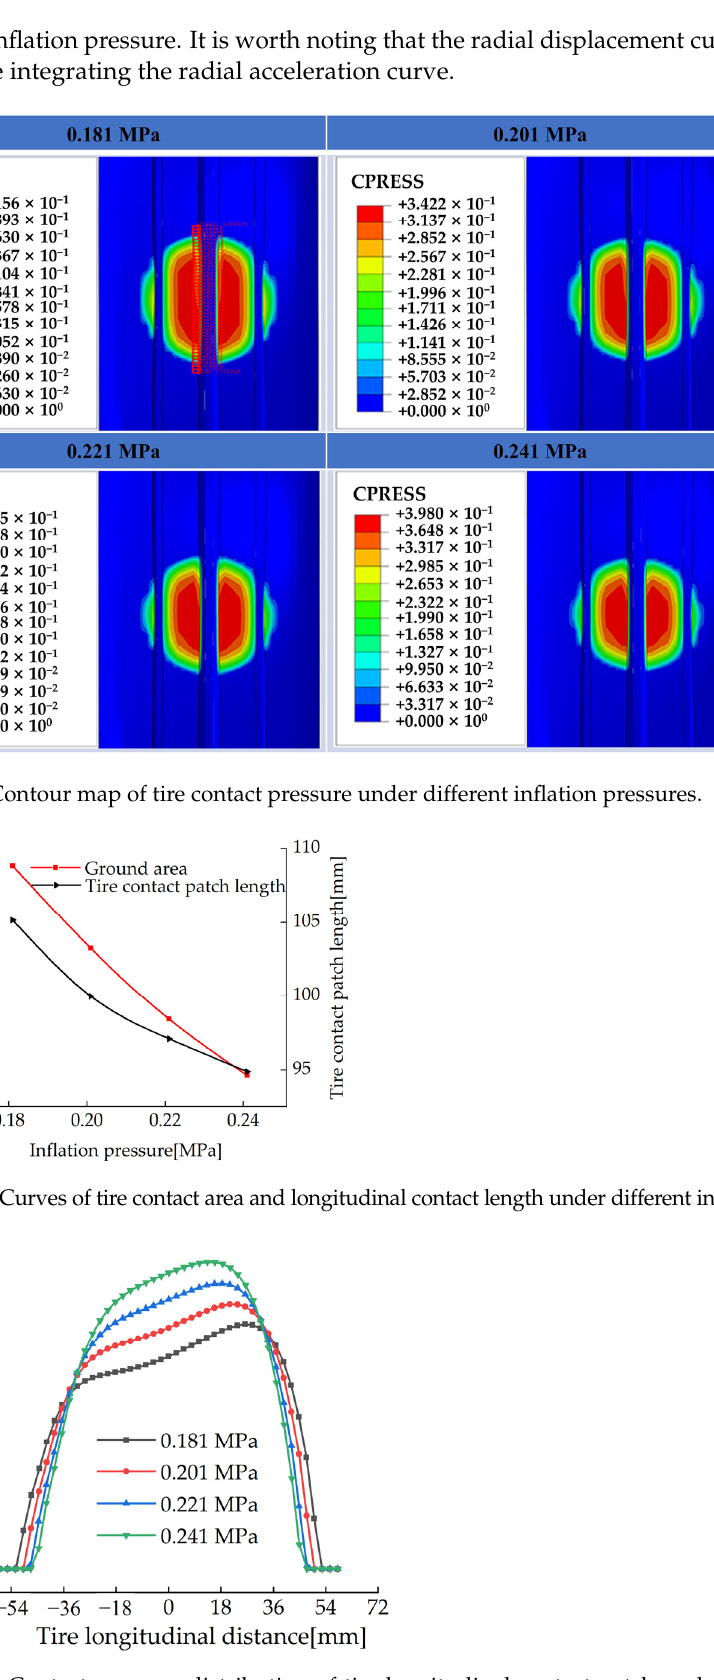
Figure 12. Variation curve of radial displacement under different inflation pressures. 4.2. The Influence of Different Loads on the Contact Patch In this section, the inflation pressure is 0.241 MPa, the speed is 30 km/h, the tread wear is 0 mm, and the range of the load is 500 N to 3500 N. As shown in Figure 13, when the load is 500 N, the tire-ground contact area is elliptical, both the long and short axes of the ellipse increase with the load increases. When the load is 2000 N, the shape of ground area is approximately rectangular. When load is 500 N, the maximum of cpress is 0.3557 MPa, and when the load is 2000 N, the maximum is 0.4007 MPa. It can be seen from Fig- ures 13 and 14 that with the increase of the tire, the tire–ground contact area and the lon- gitudinal length of the contact patch have a larger increase. In addition, it can be seen from Figure 14 that there is a significant linear relationship between the tire load and the longi- tudinal length of the ground area. It can be seen from Figures 13 and 15 that with the increase of the load, the extreme value of the ground stress in the grounding area is still symmetrically distributed on both sides of the middle longitudinal groove but only in- creases in the longitudinal length. It is worth noting that when the load increases to 1500 N, the cpress value in the central area of the ground trace shows a decreasing trend. This is due to the stress on the tire shoulder gradually increases with the increase of the load, resulting in a “warping” phenomenon of the tread in the tire contact area, which eventu- ally leads to a decrease in cpress. As shown in Figure 16, the maximum value of the radial displacement increases with the increase of the load.